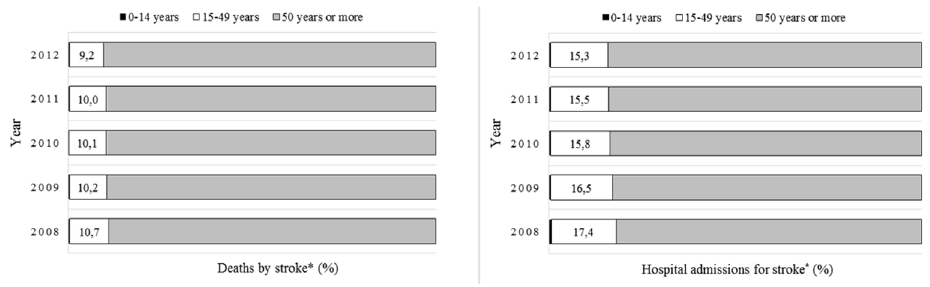
Fig 1. Distribution of deaths and hospital admissions for stroke * in Brazilians between 2008 and 2012. * International classification of diseases, 10th revision. Codes I60 to I64. [11] Source: Mortality Information System (SIM) and Hospital Information System (SIH/SUS). Data made available by the Department of Informatics of The National Health System (DATASUS — www.datasus.gov.br). Ministry of Health,